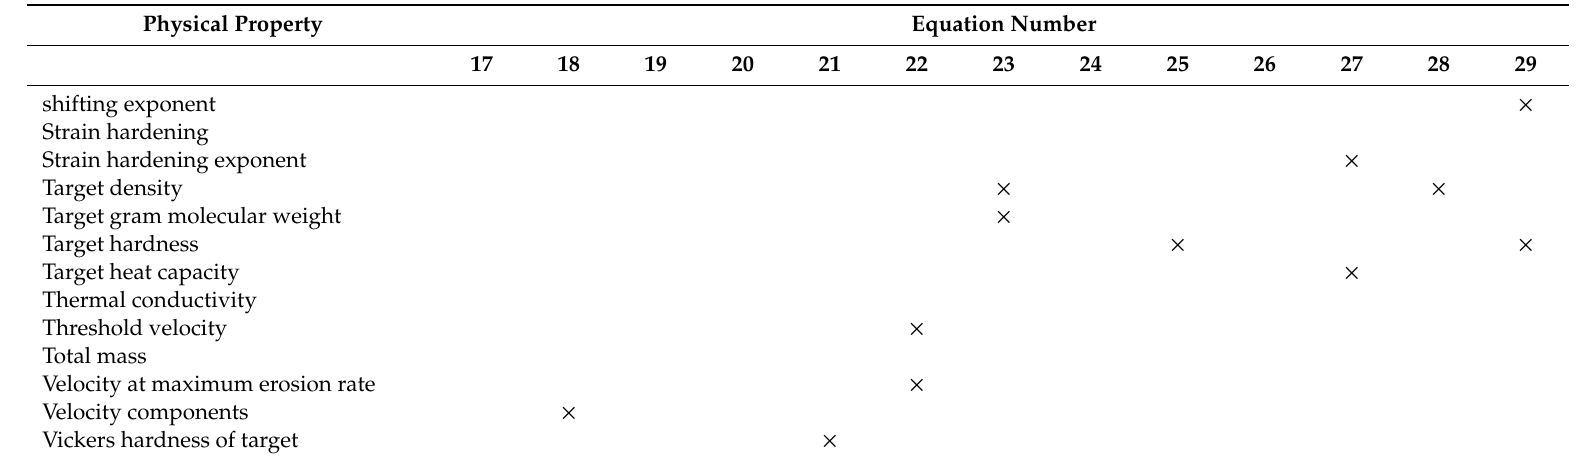
Table 4. Physical parameters used in erosion models